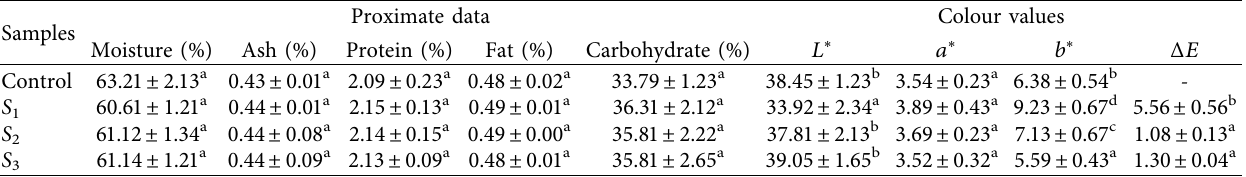
Table 2: Proximate and colour data of the samples.